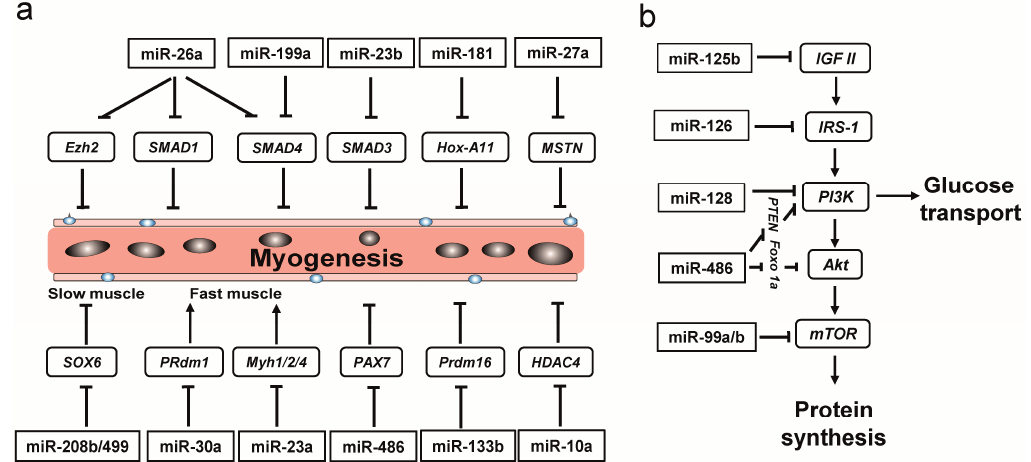
Figure 4. Schematic of the regulatory mechanism for myogenesis by PL-enriched miRNAs via targeting ( a ) myogenic regulatory factors and ( b ) insulin-like growth factor (IGF) pathways. The blue and black circles in ( a ) indicated satellite cells and cell nucleus in the myofiber (light brown tube),